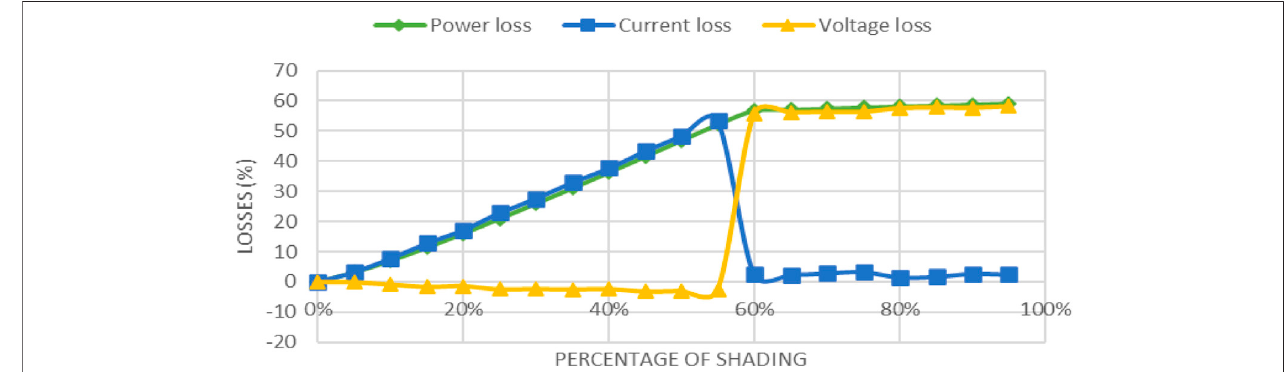
FIGURE 8 | Annual power, current and voltage losses curves.